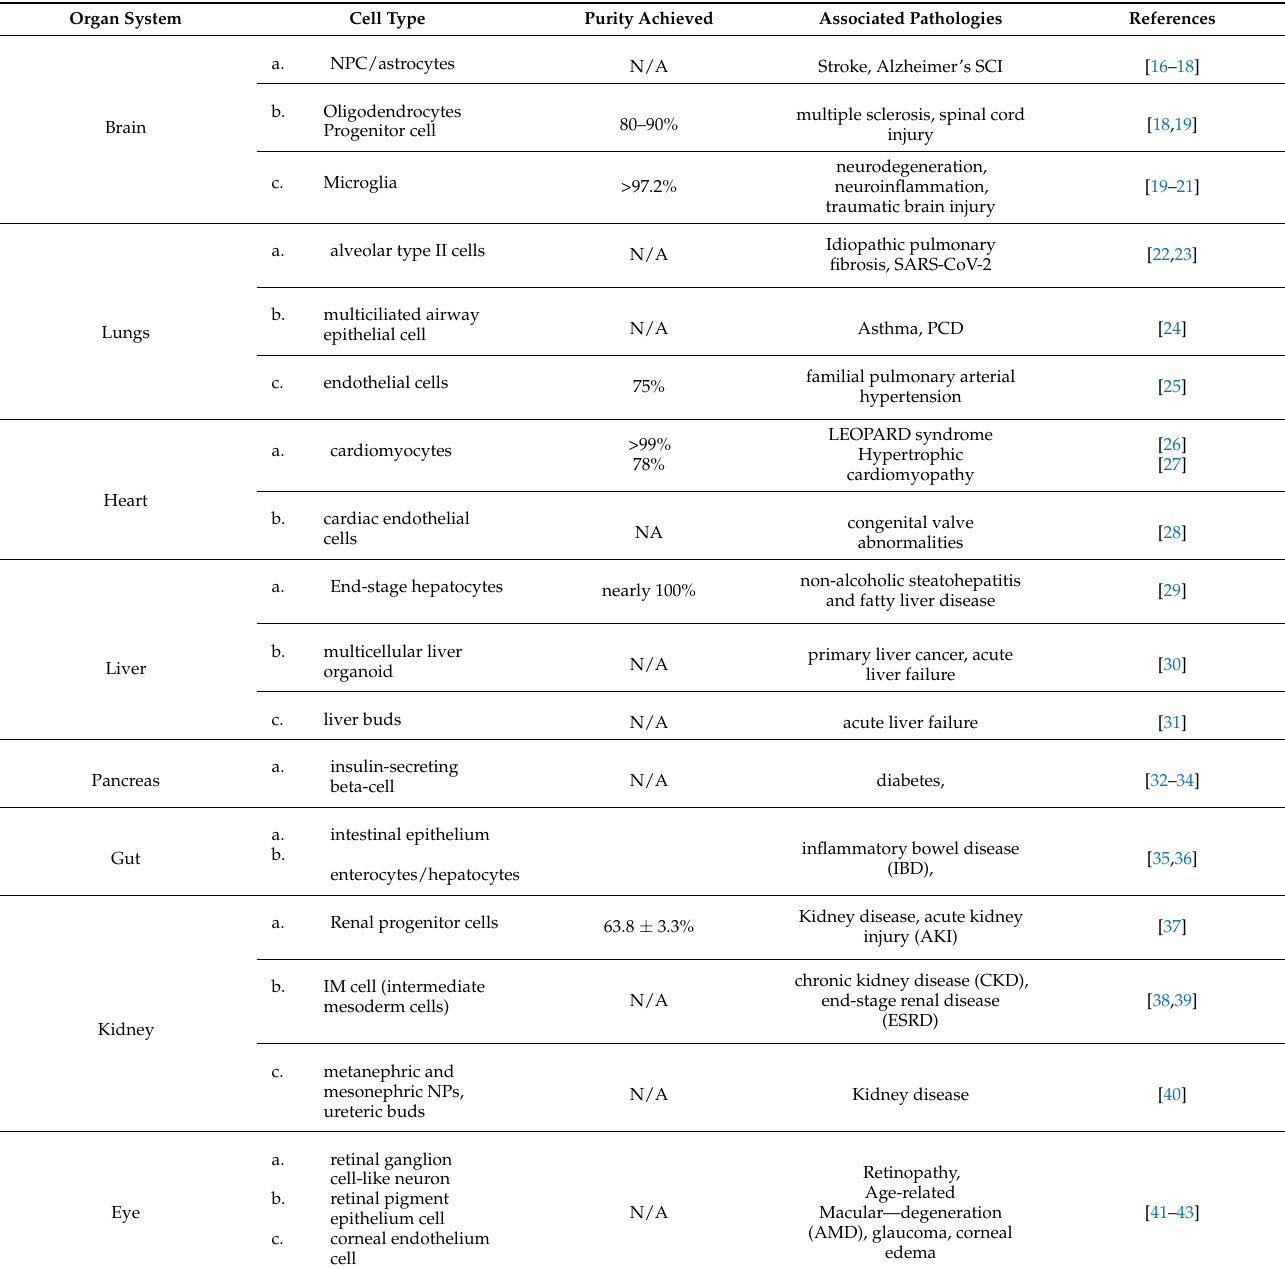
Table 1. List of clinically relevant phenotypic cells derived from hPSCs by differentiation protocols and their purity at the end of the differentiation